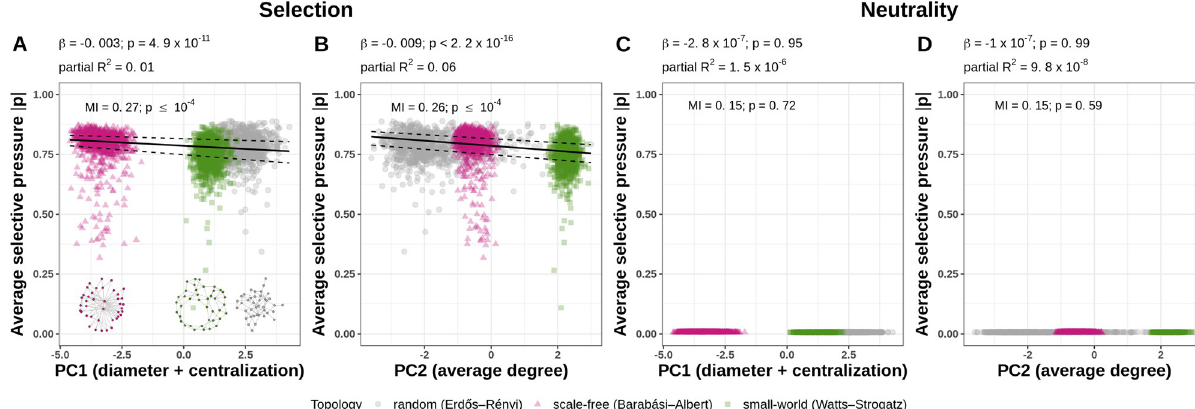
Fig 6. Global network properties affect the average selective pressure acting on gene expression noise under stabilizing selection on gene expression level. A, B —Principal component variables consisting of the diameter and network centralization (A) and average degree (B) have a significant negative effect on the average selective pressure per network. The two synthetic variables were constructed by performing a principal component analysis on 12 graph-level network metrics. The lines indicate the 25% (lower dashed line), 50% (solid line), and 75% (upper dashed line) fitted quantiles. The dataset consisted of 3,000 populations with unique 40-gene random, scale-free and small-world network topology samples, which were independently evolved 10 times under selection and 10 times under neutrality. The selective pressure on each gene is calculated as the average normalized reduction of the intrinsic noise parameter during the evolutionary simulation and summarized over all replicates in each scenario. Coefficients and p-values are estimated using a linear model with average selective pressure as the response variable, and PC1 and PC2 as explanatory variables. Mutual information (MI) p-values were computed with permutation test with 10,000 permutations. had a significant effect on the average selective pressure per network (linear model with syn- thetic network diameter and centralization coefficient β = − 2.8 × 10 − 7 , p-value = 0.95; synthetic